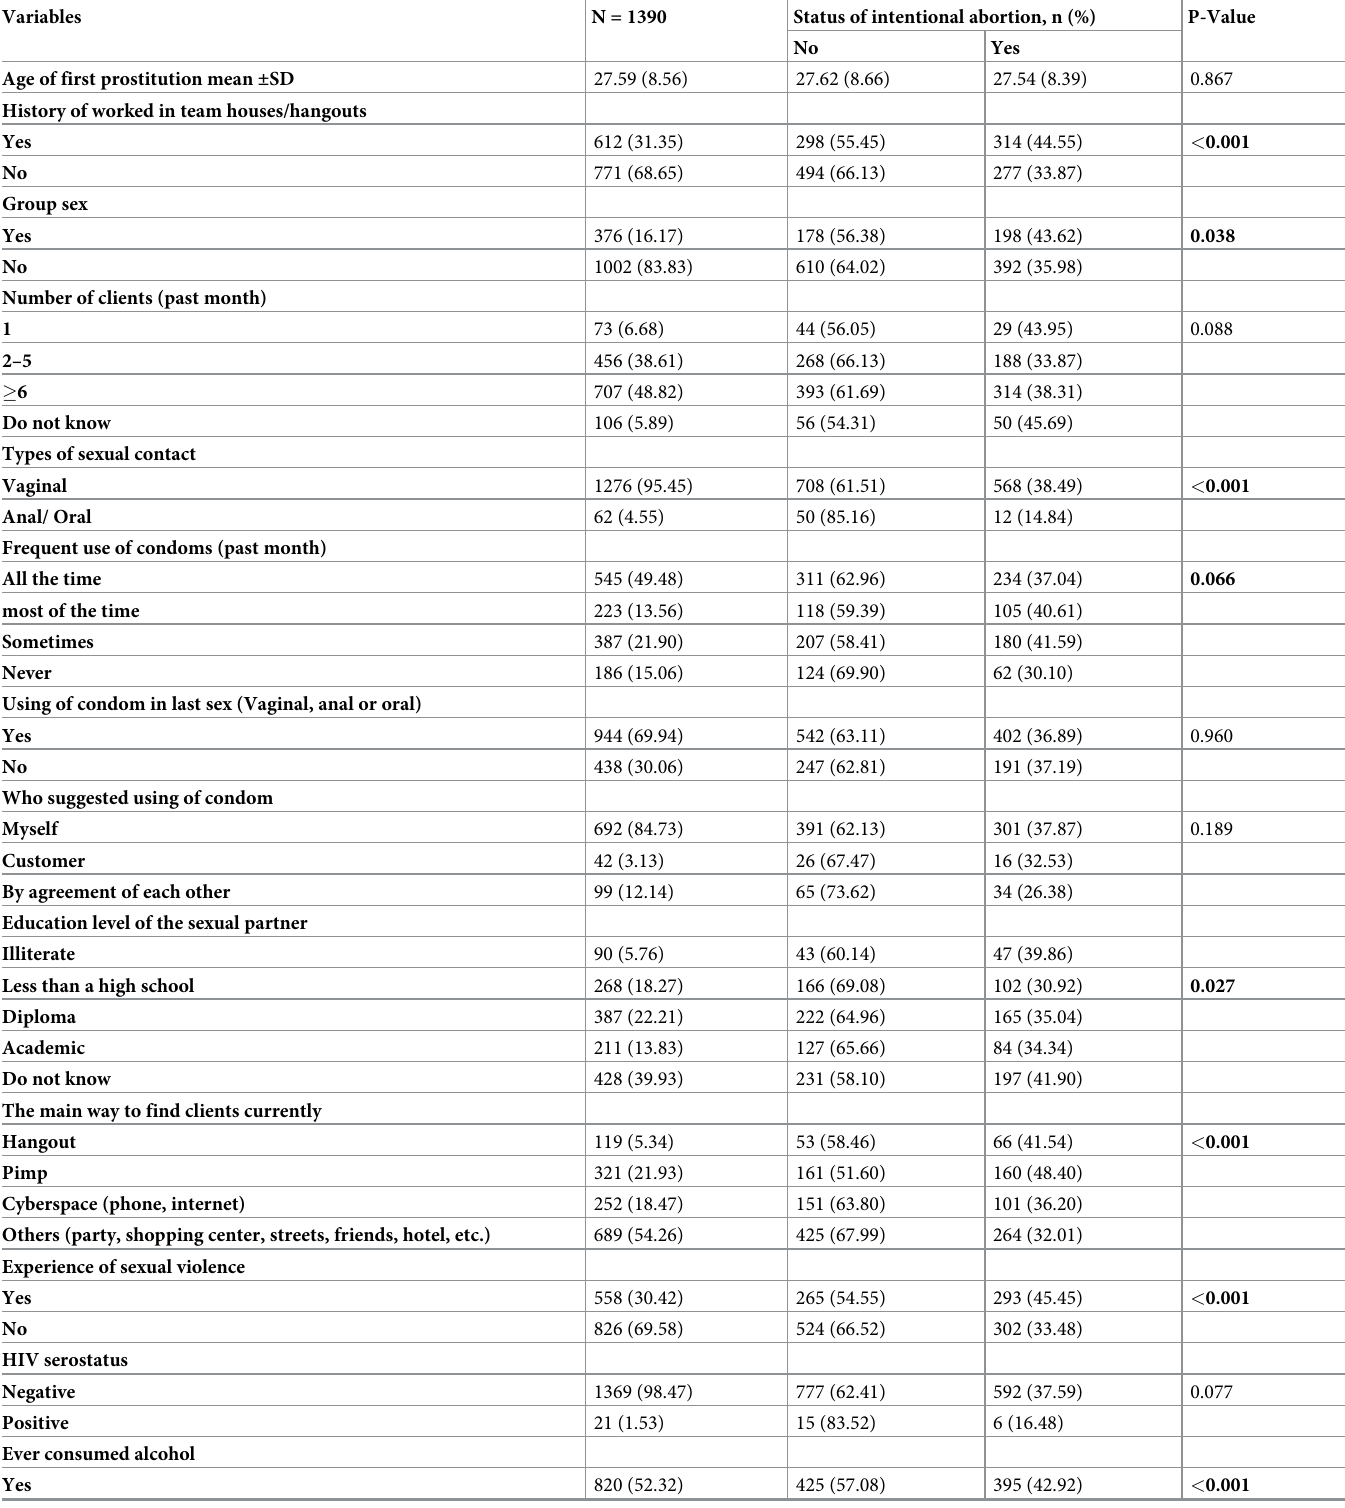
Table 2. Sexual behavior and intentional abortion among female sex workers in